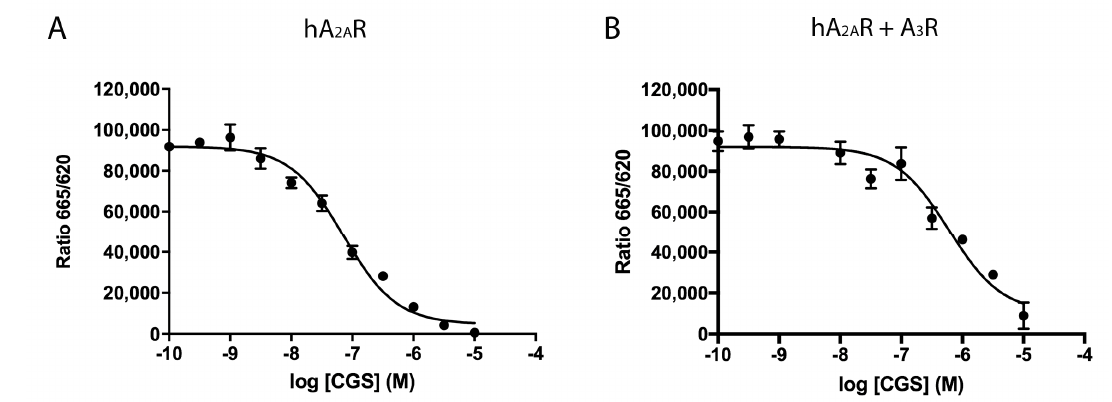
Figure 2. Competition experiments of SCH 442416 red ligand binding to living HEK-293T cells expressing A 2A R or A 2A R/A 3 R-Hets. HEK-293T cells were transfected with 1 µg cDNA for HALO– A 2A R in the presence ( B ) or in the absence ( A ) of 0.5 µg cDNA for A 3 R. Competition binding curves were obtained by Homogeneous Time Resolved Fluorescence (HTRF) using 20 nM red SCH 442416 with increasing concentrations of CGS 21680 (A 2A R agonist) (0–10 µM). Data are the mean ± S.E.M. of a representative experiment performed in triplicates. HTRF ratio = 665 nm acceptor signal/620 nm donor signal × 10,000.